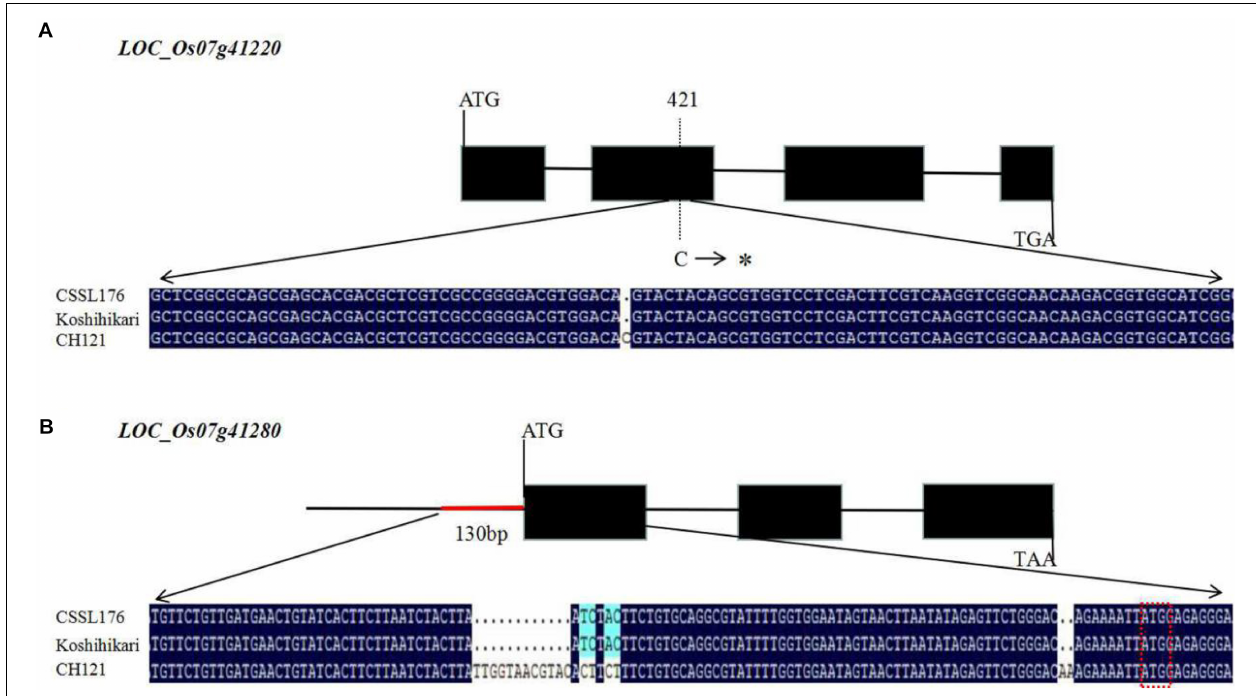
FIGURE 6 | Structure and sequence alignment of candidate genes. (A) Gene structure of LOC_Os07g41220 and sequence differences in LOC_Os07g41220 between CH121 and CSSL176 (B) Gene structure of LOC_Os07g41280 and sequence differences in LOC_Os07g41280 between CH121 and CSSL176. The three base sequences in the red box are the start codon. The symbol * means the C deletion.